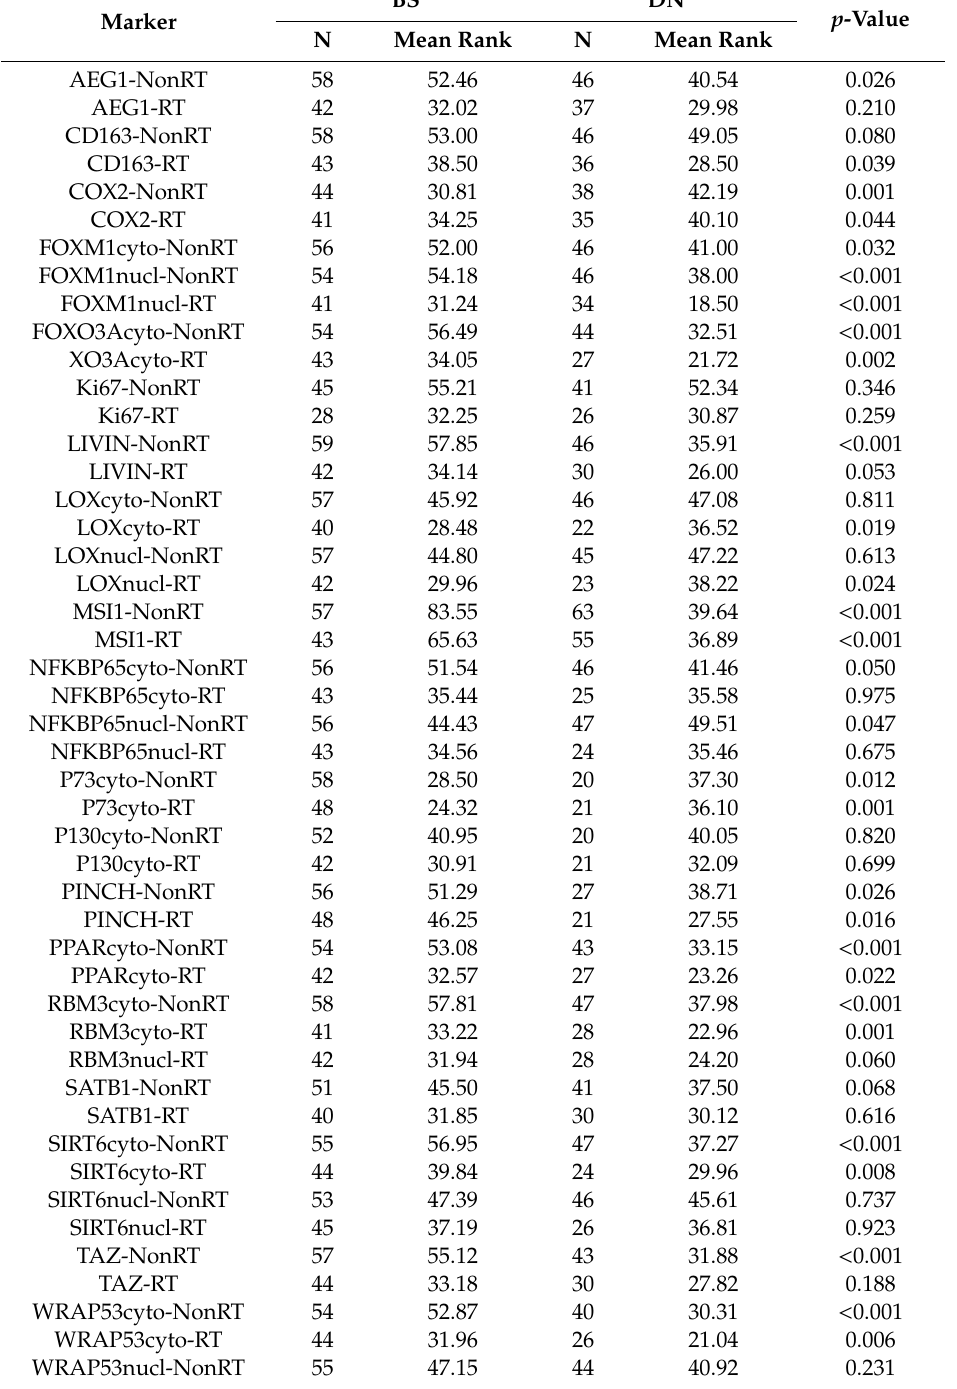
Table 1. Comparing the expression of biomarkers between biopsy samples and distant normal samples in Non-RT group or RT group to clarify their diagnostic